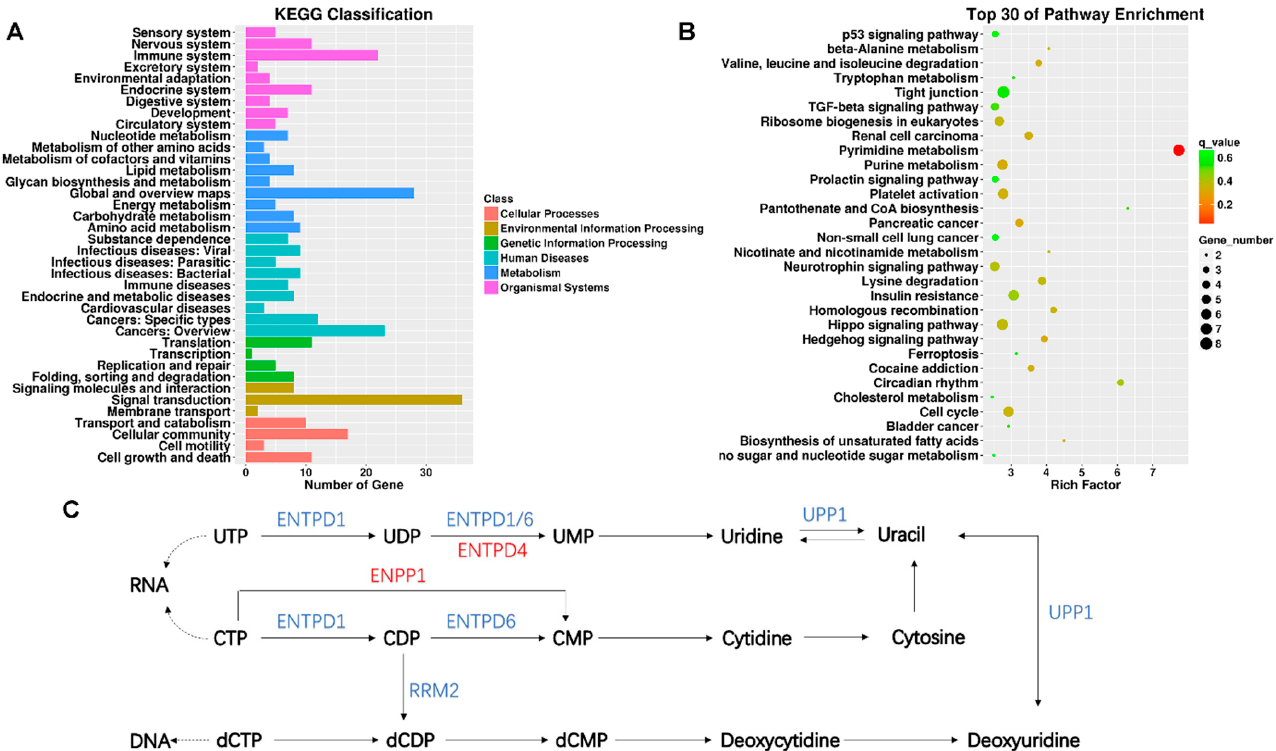
Figure 3. KEGG analysis of differentially expressed lncRNAs target genes. ( A ) The number of genes in different KEGG classifications is shown; ( B ) the results of KEGG pathway enrichment analysis of differentially expressed genes are shown in scatter plots. Where Rich Factor = (the number of differential genes in a KEGG term/the number of differential genes in the KEGG database)/(the number of genes in a KEGG term/the number of genes in the KEGG database). The degree of enrichment increases with the rich factor. The more significant the enrichment, the smaller the value of the q value, which is the p value after multiple hypothesis testing has been corrected. In the Rich Factor, only the top 30 KEGG entries are displayed; ( C ) showing altered pathways in pyrimidine metabolism, blue is the gene with decreased expression compared to the control group, and red is the gene with increased expression compared to the control group.